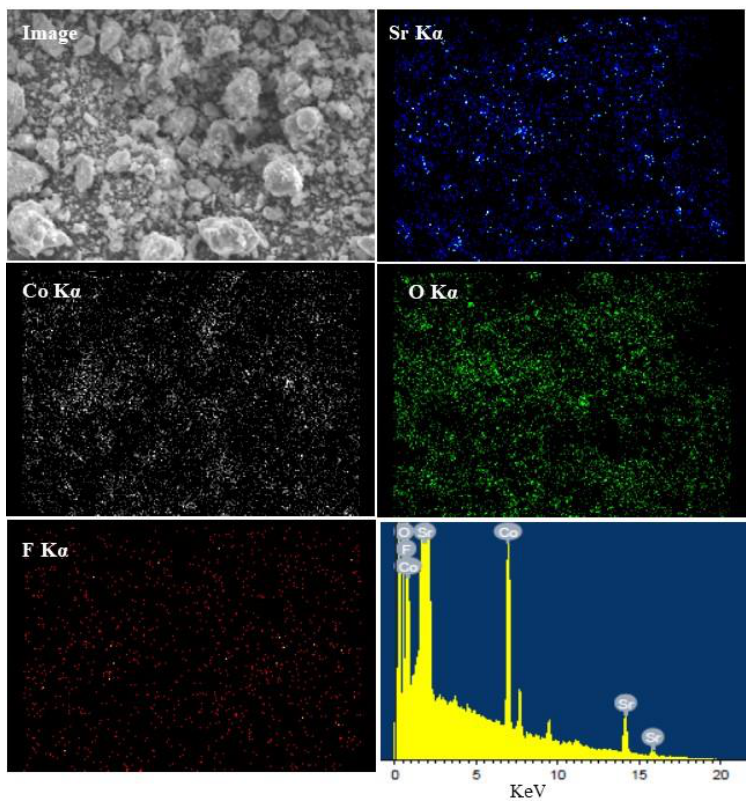
Figure 2. SEM images of ( a ), ( b ) Sr 2 CoO 3 F, ( c ) Sr 2 CoO 3 Cl, and ( d ) Sr 2 CoO 3 Br catalysts.